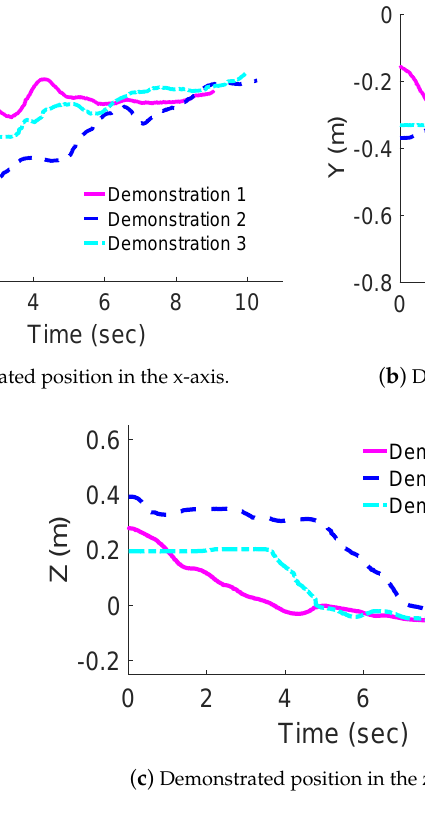
Figure 7. Demonstrated observations in process of